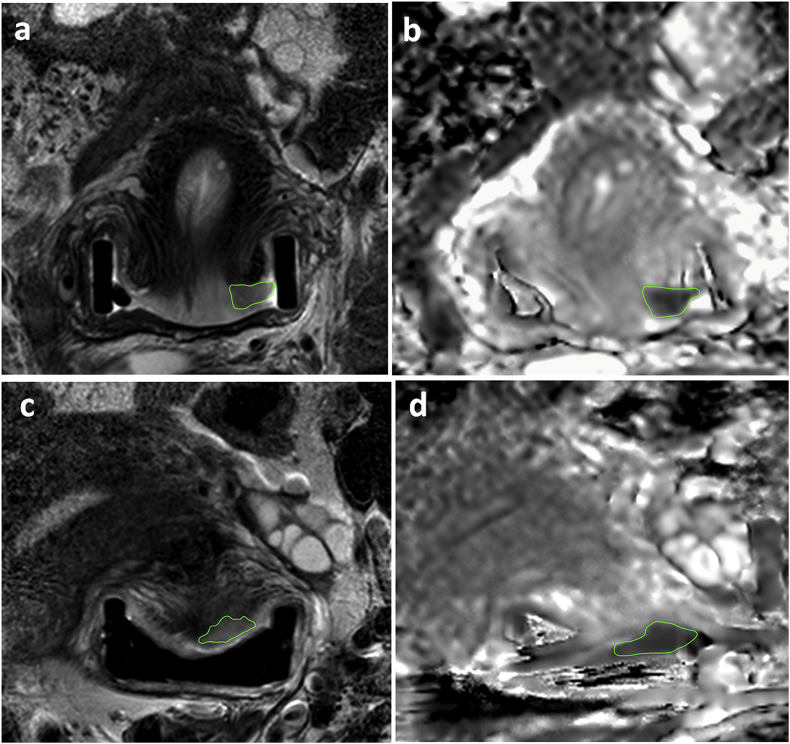
T2-W (a) and ADC map (b) in a 33- year old patient with a 0.8 cm3 volume tumor that had high dissimilarity (0.808). Regions-of-interest delineate the tumor. The intermediate signal-intensity tumor on the T2-W imaging is restricted in diffusion on the ADC maps. Tumor was confined to the cervix, and the patient remains disease-free following trachelectomy. T2-W (c) and ADC map (d) in a 26 year old patient with a 0.9 cm3 volume tumor that had low dissimilarity (0.489). The intermediate signal-intensity tumor on the T2-W imaging (c) is restricted in diffusion on the ADC maps (d). Regions-of-interest delineate the tumor. Tumor was confined to the cervix, but despite negative nodes on surgical histology, the patient recurred centrally after 9 months.